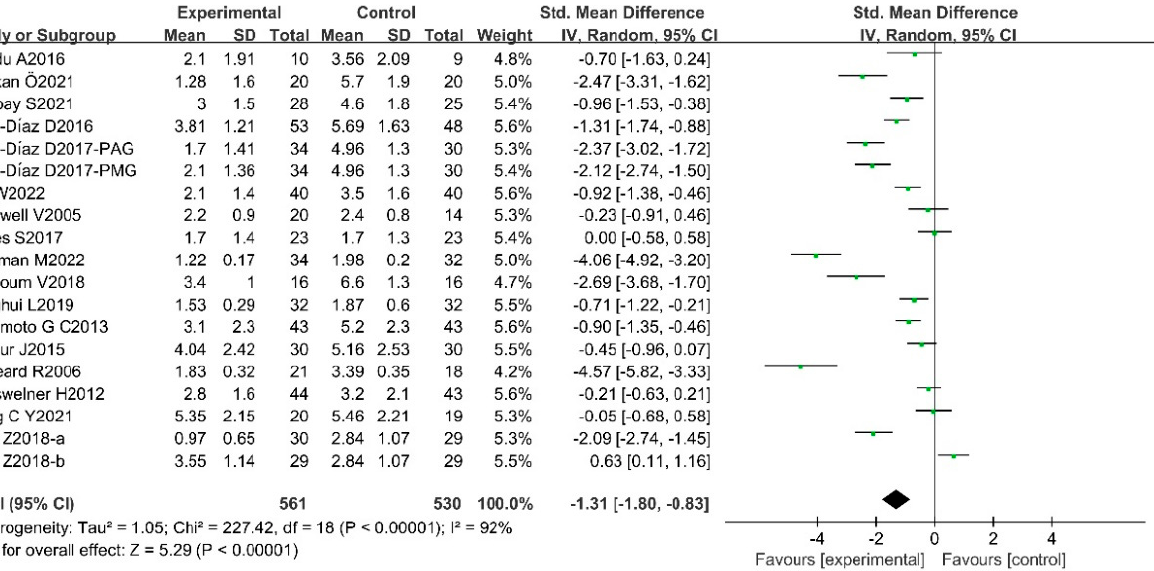
Figure 5. Meta-analysis of the effect of Pilates on ODI in CLBP patients [12,19,20,46,50–53,55]. Figure 6. Meta-analysis of the effect of Pilates on RMDQ in CLBP patients [20,23,36,48,49,51,54].